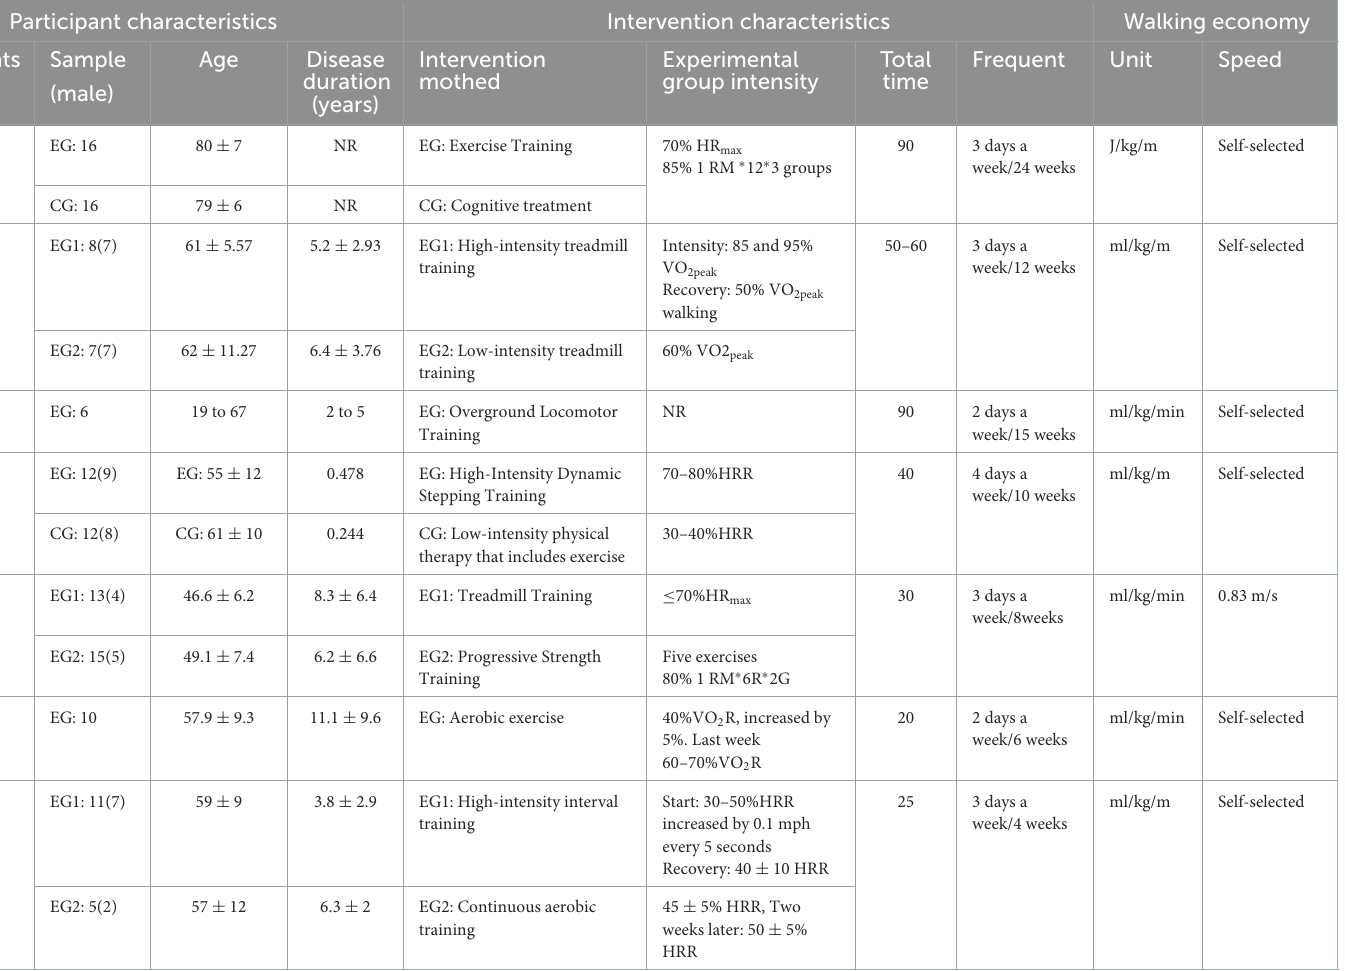
TABLE 1 Summary characteristics of the 22 included